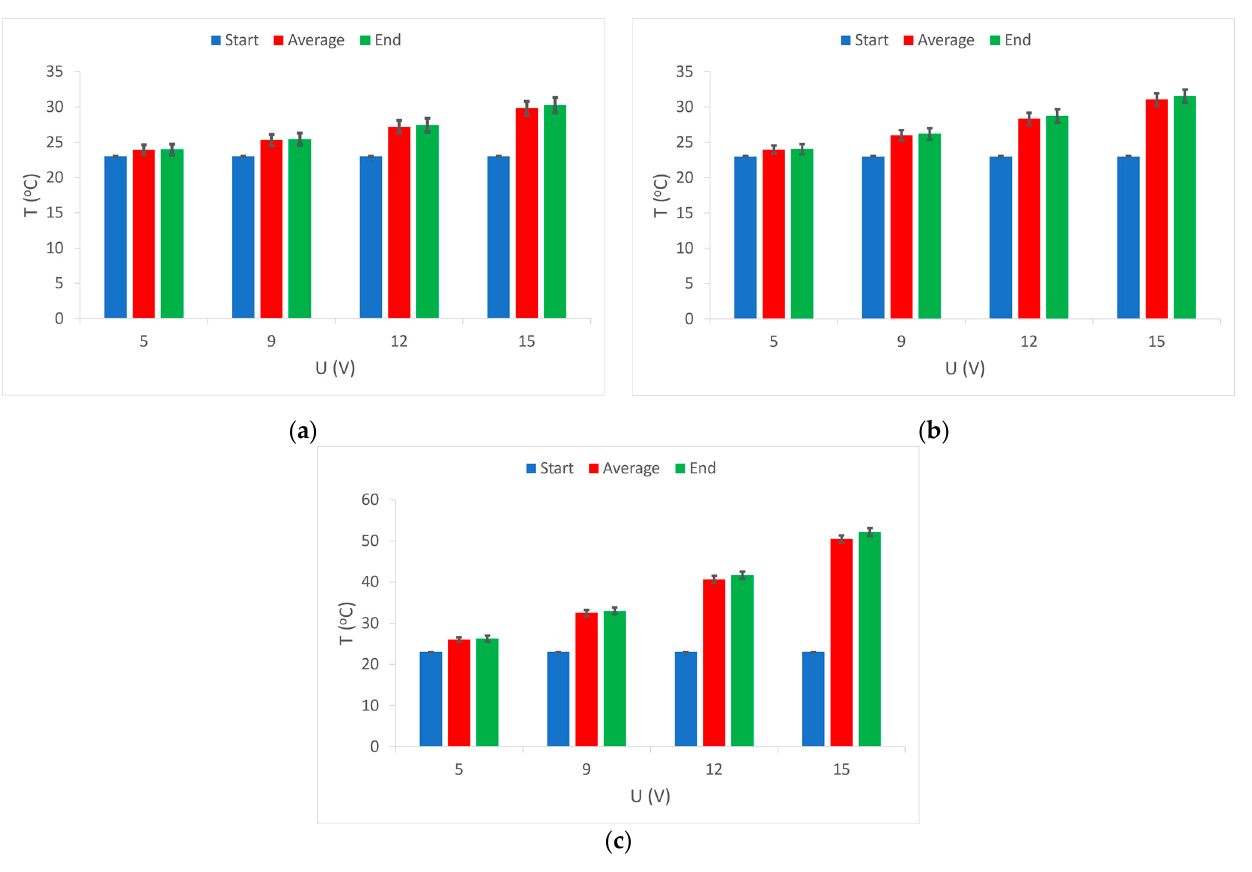
Figure 8. Temperature measurement results at selected voltage values: ( a ) sample 1; ( b ) sample 2; ( c ) sample 3.